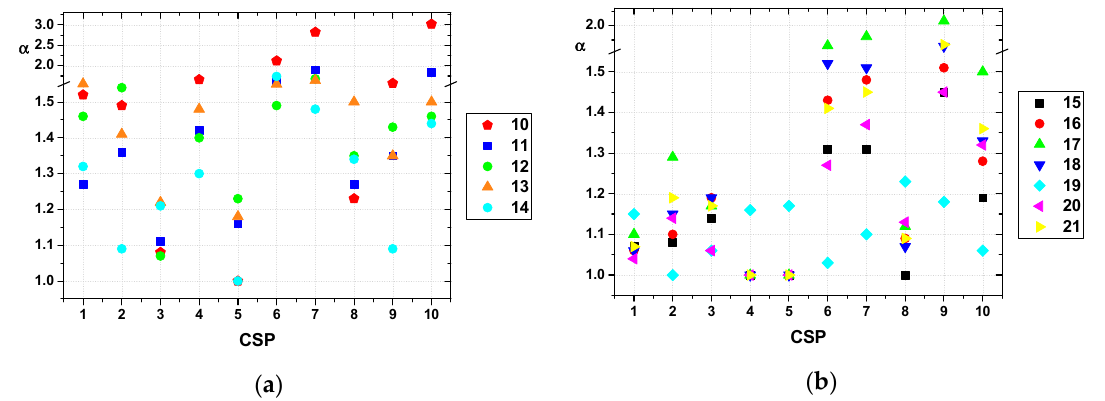
Figure 4. Separation factors of compounds 10 – 14 ( a ) and 15 – 21 ( b ) on prepared CSP-1 – CSP-10 , mobile phase hexane-2-propanol = 80:20.